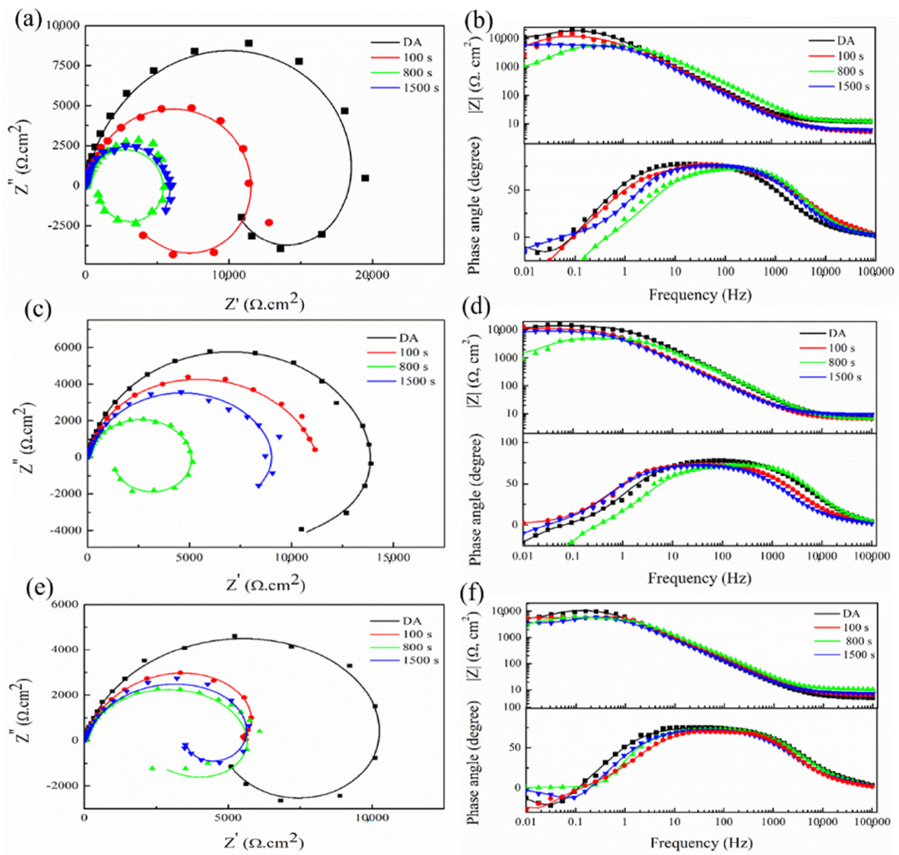
Figure 7. The Nyquist and Bode plots of tested sample under DA state and 295 °C in different isothermal holding time (The point represents the actual measurement results and the solid line stands the fitting results): ( a , b ) 0 h; ( c , d ) 48 h; ( e , f ) 96 h.